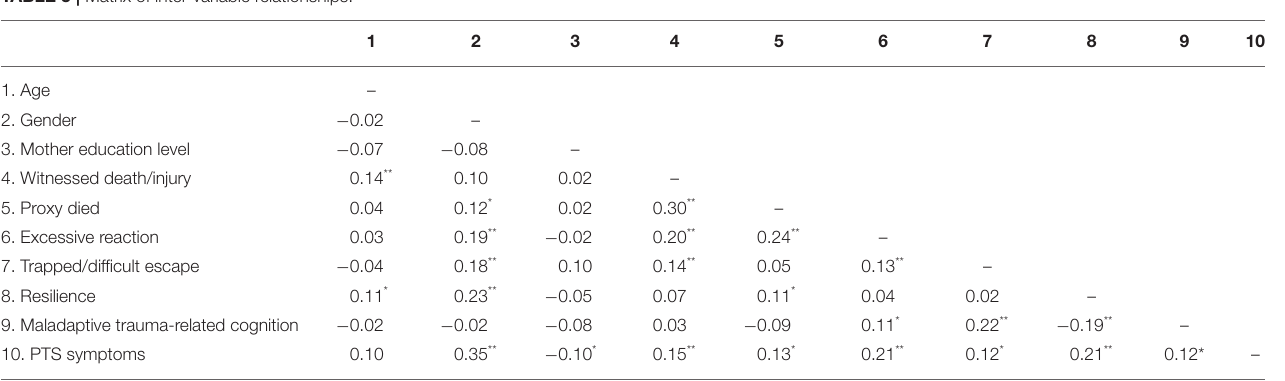
TABLE 3 | Matrix of inter-variable